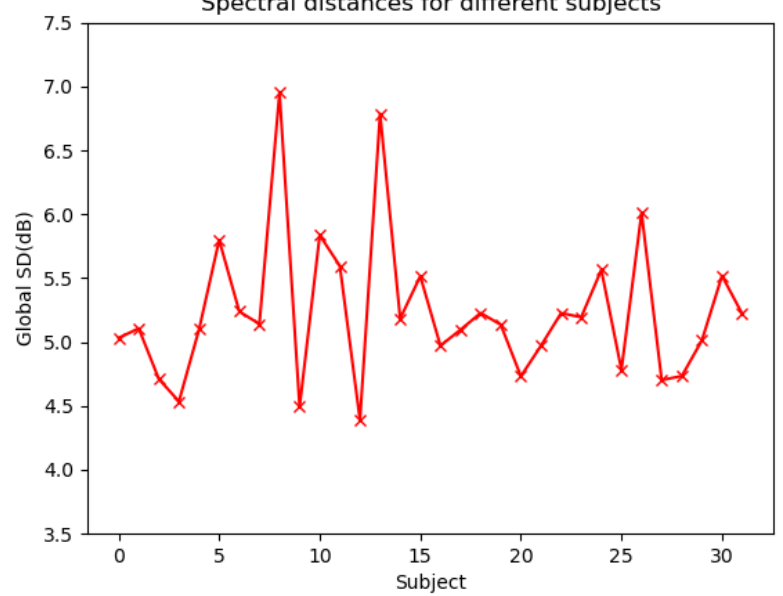
Figure 12. Spectral distances for different